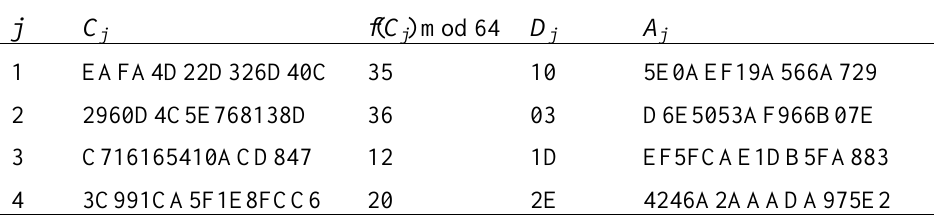
Table 1. Decryption of C1 using